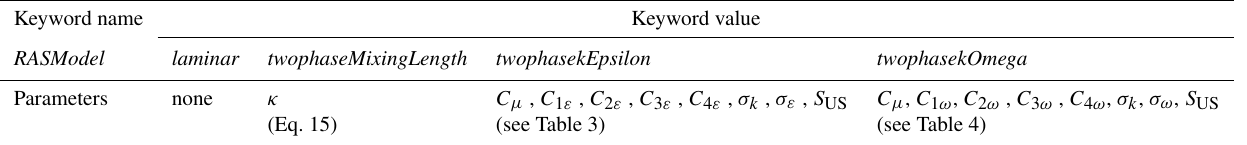
Table 5. List of the turbulence models that can be selected through the keyword RASModel . Keyword name Keyword value RASModel laminar twophaseMixingLength twophasekEpsilon twophasekOmega